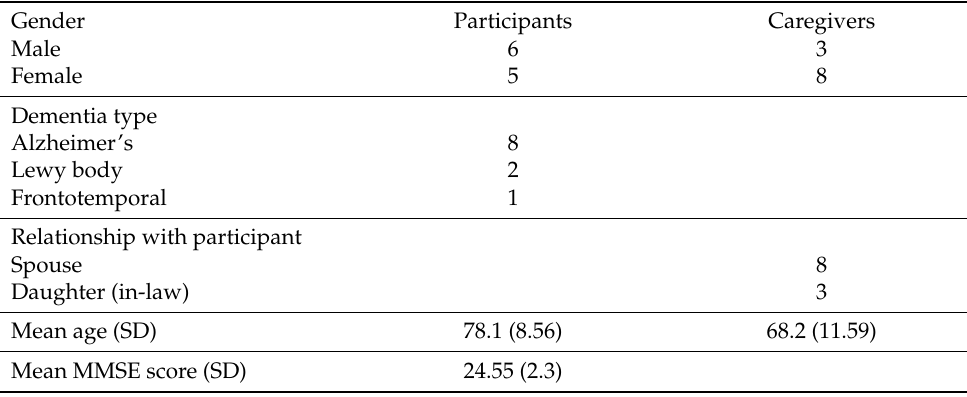
Table 1. Participant and caregiver demographic variables at baseline ( n =